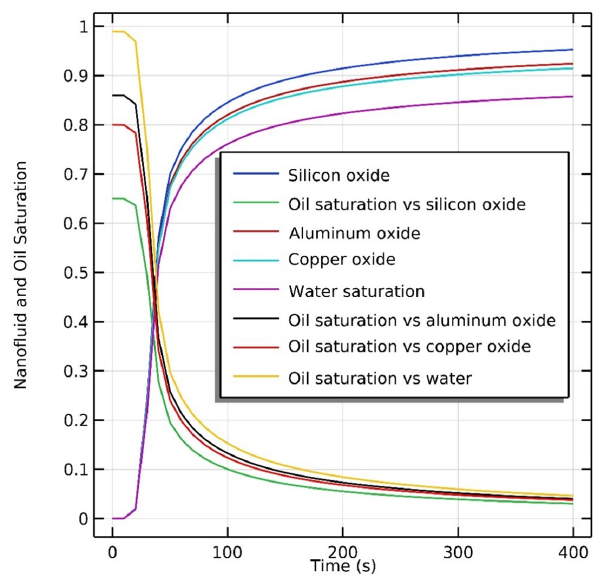
Figure 7. Saturation of nanofluid and oil versus